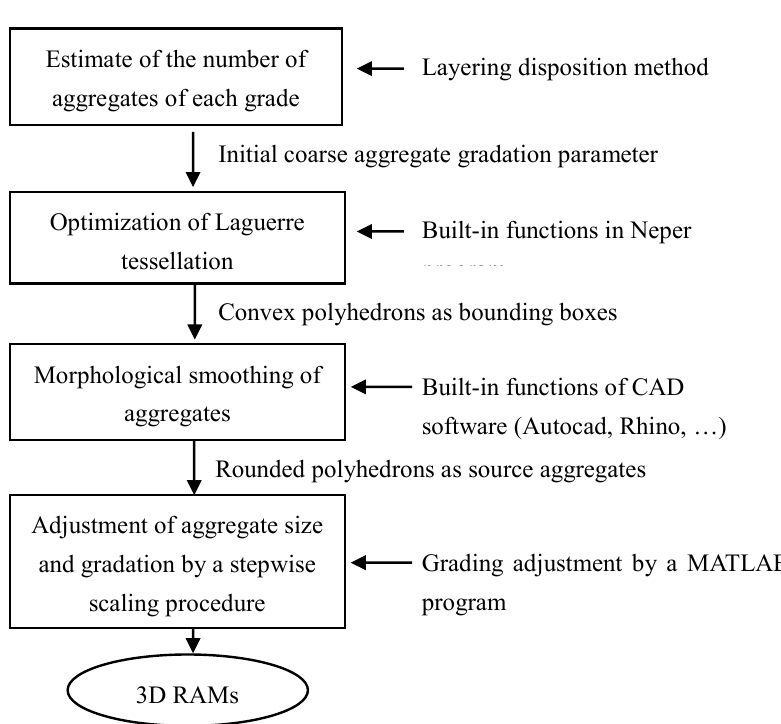
Fig. 1 Flowchart of generating 3D RAMs of concrete Figure 1. Flowchart of generating 3D random aggregate models (RAMs) of